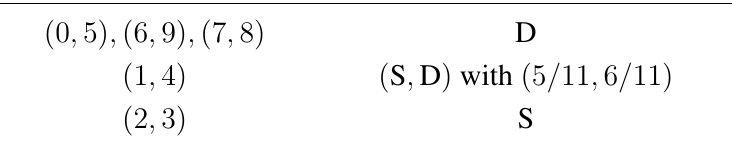
Table 4. A pair of optimal mixed strategies in Model A3. For Banker’s fully specified optimal strategy, see Table 5 with d